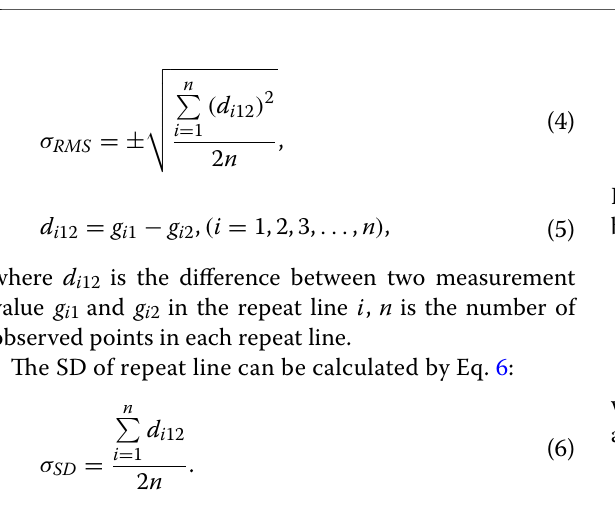
Fig. 5 Comparison of free-air gravity anomaly ( a ) results from measurements collected with all the gravimeters on the three times repeated Line 2 (ref. to Fig. 3); b , c sea conditions during the survey can be envisaged from roll and pitch vessel